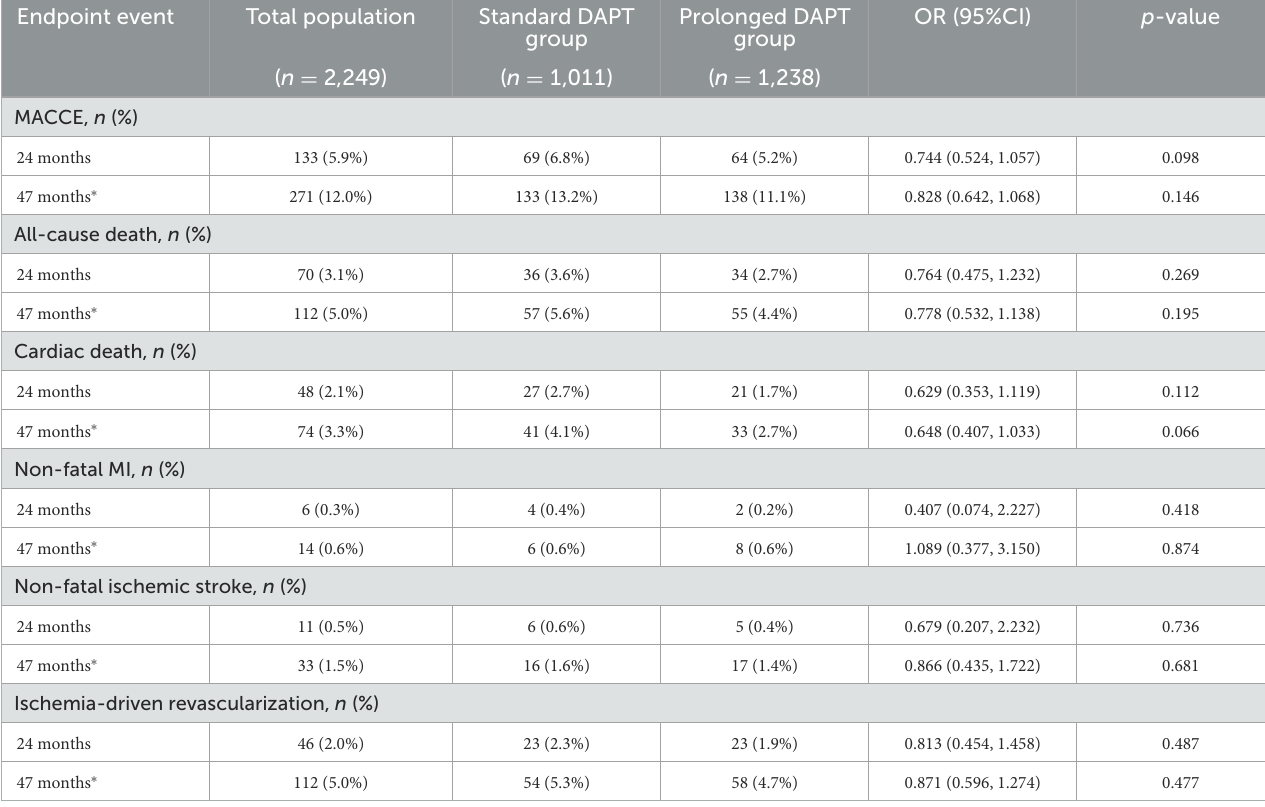
TABLE 2 Incidence of MACCEs in the standard and prolonged DAPT